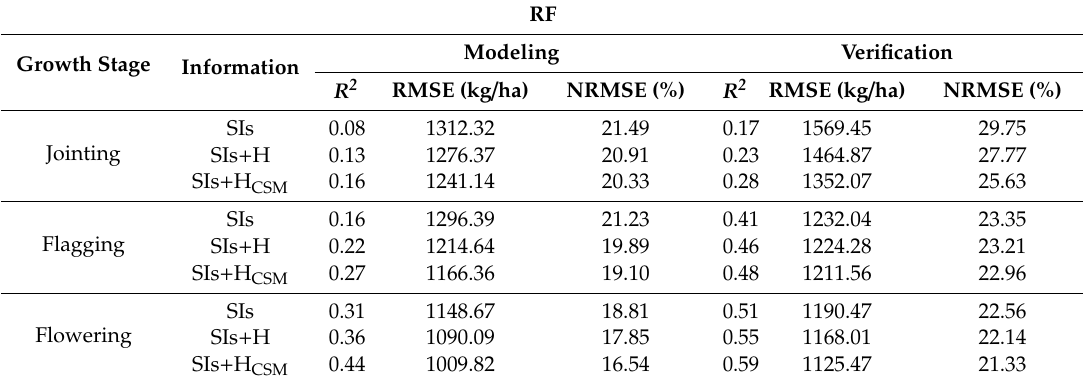
Table 6. Results of the estimation of the yield of winter wheat in di ff erent growth stages by using the random forest (RF)